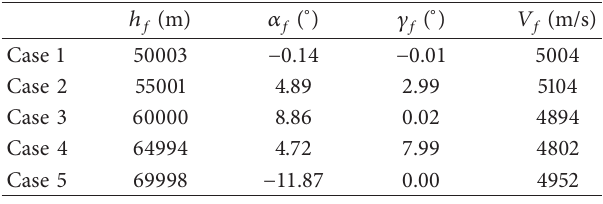
Table 2: Initial states.